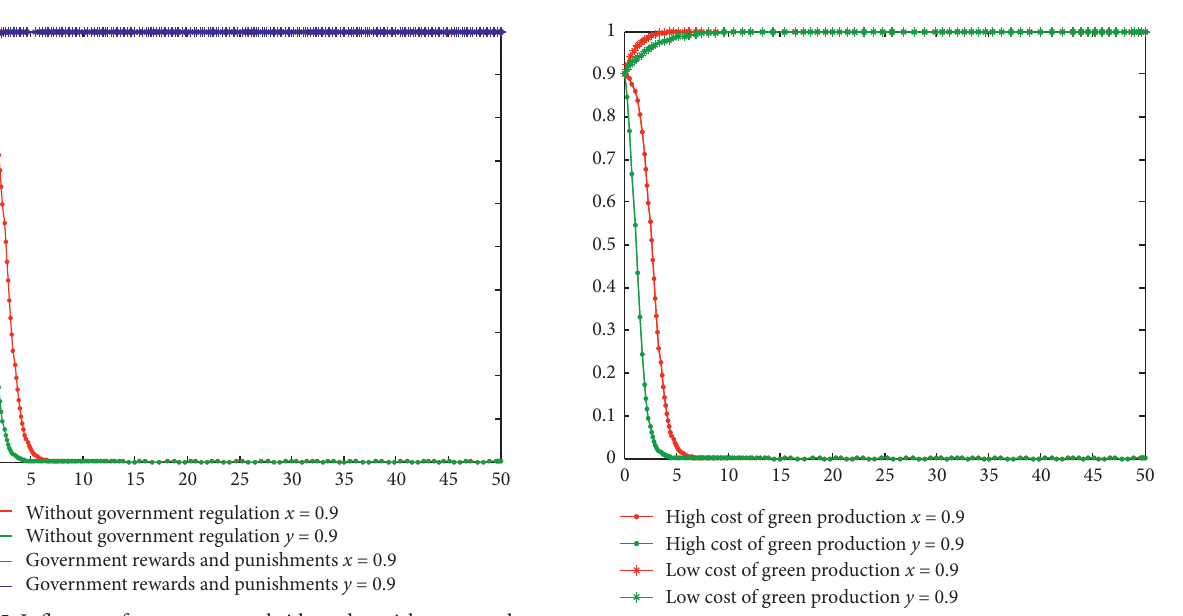
Figure 7: Influence of green production cost on the formation of green dairy industry chain.